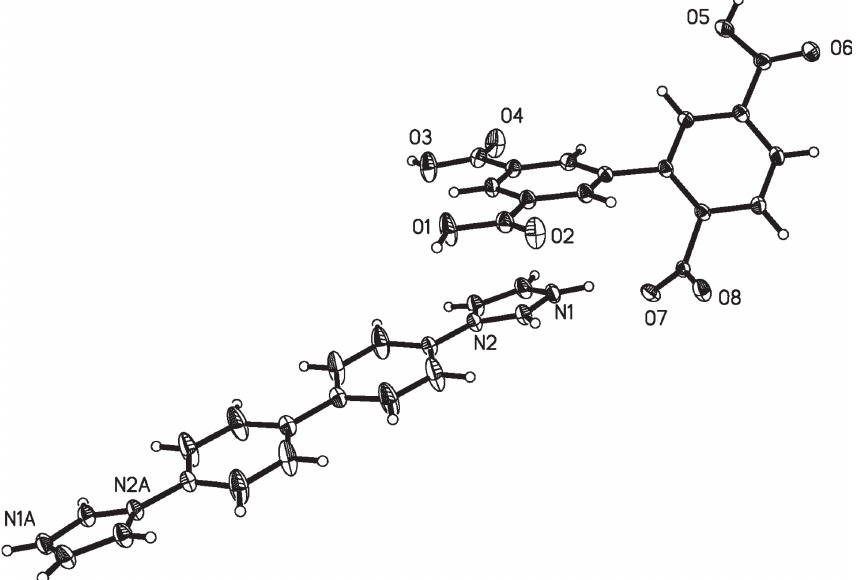
Table 1 contains crystallographic data and Table 2 contains the list of the atoms including atomic coordinates and dis- placement parameters.